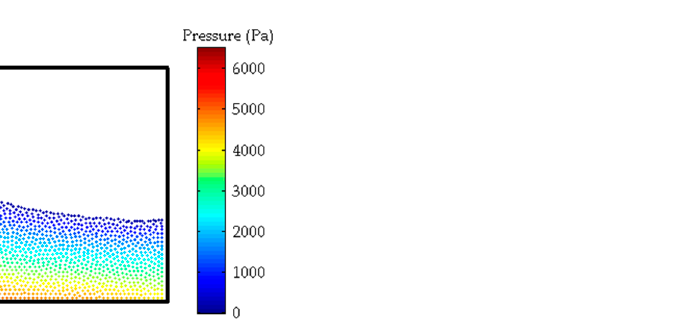
( 1.33 . ( h = 1.33 ∆ x , ∆ x = 0.02 m ) .